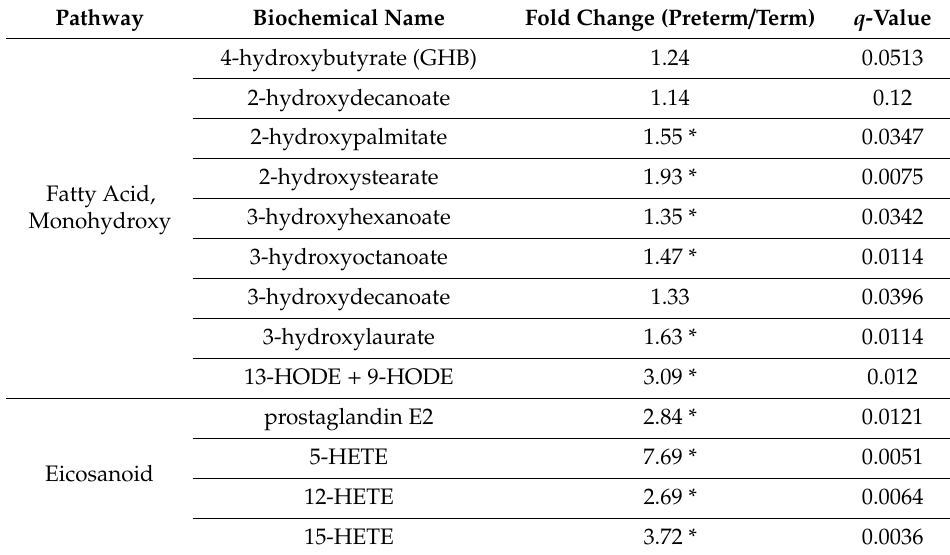
Table 3. Fold change in prostaglandins and monohydroxy fatty acids in